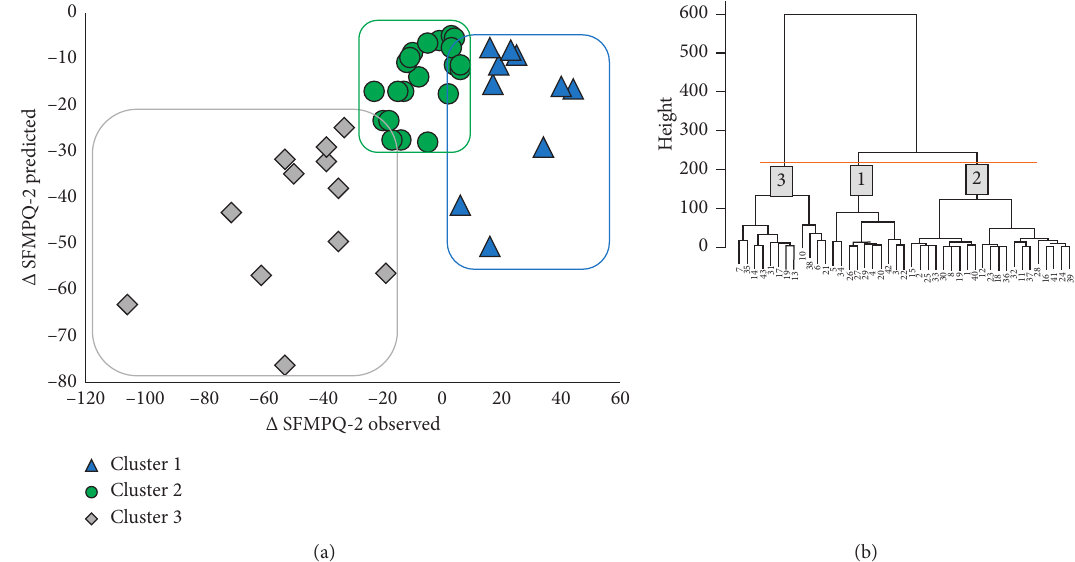
Figure 2: (a) The scatter plot of the ∆ SFMPQ-2 observed score and ∆ SFMPQ-2 predicted score. Triangle indicates cluster 1. Circle indicates cluster 2. Rhombus indicates cluster 3. (b) Dendrogram of cluster analysis. Abbreviations: SFMPQ-2, Short-Form McGill Pain Ques- tionnaire-2; ∆ , follow-up score minus the initial score.